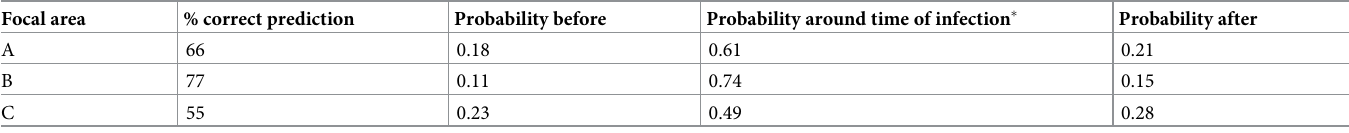
Table 4. Cross validation results for infected houses. Focal area